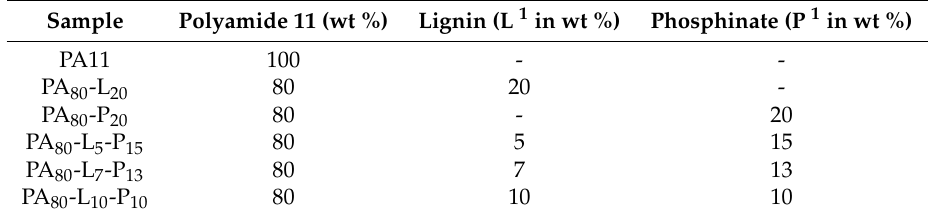
Table 1. Polyamide 11 (PA11) blend formulations with different lignin and phosphinate. Sample Polyamide 11 (wt %) Lignin (L 1 in wt